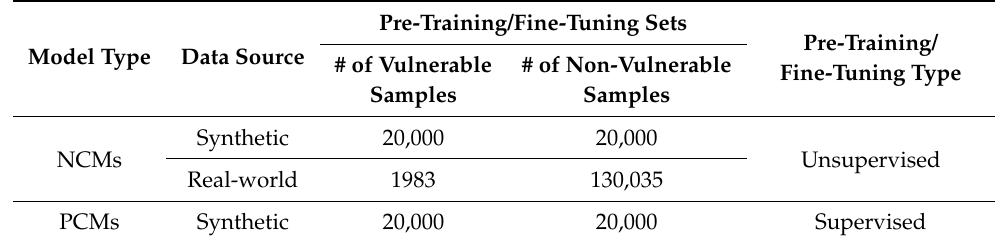
Table 3. The experiment setting for answering RQ1-3, listing the data sources for pre-training/fine- tuning the non-contextualized and contextualized models.